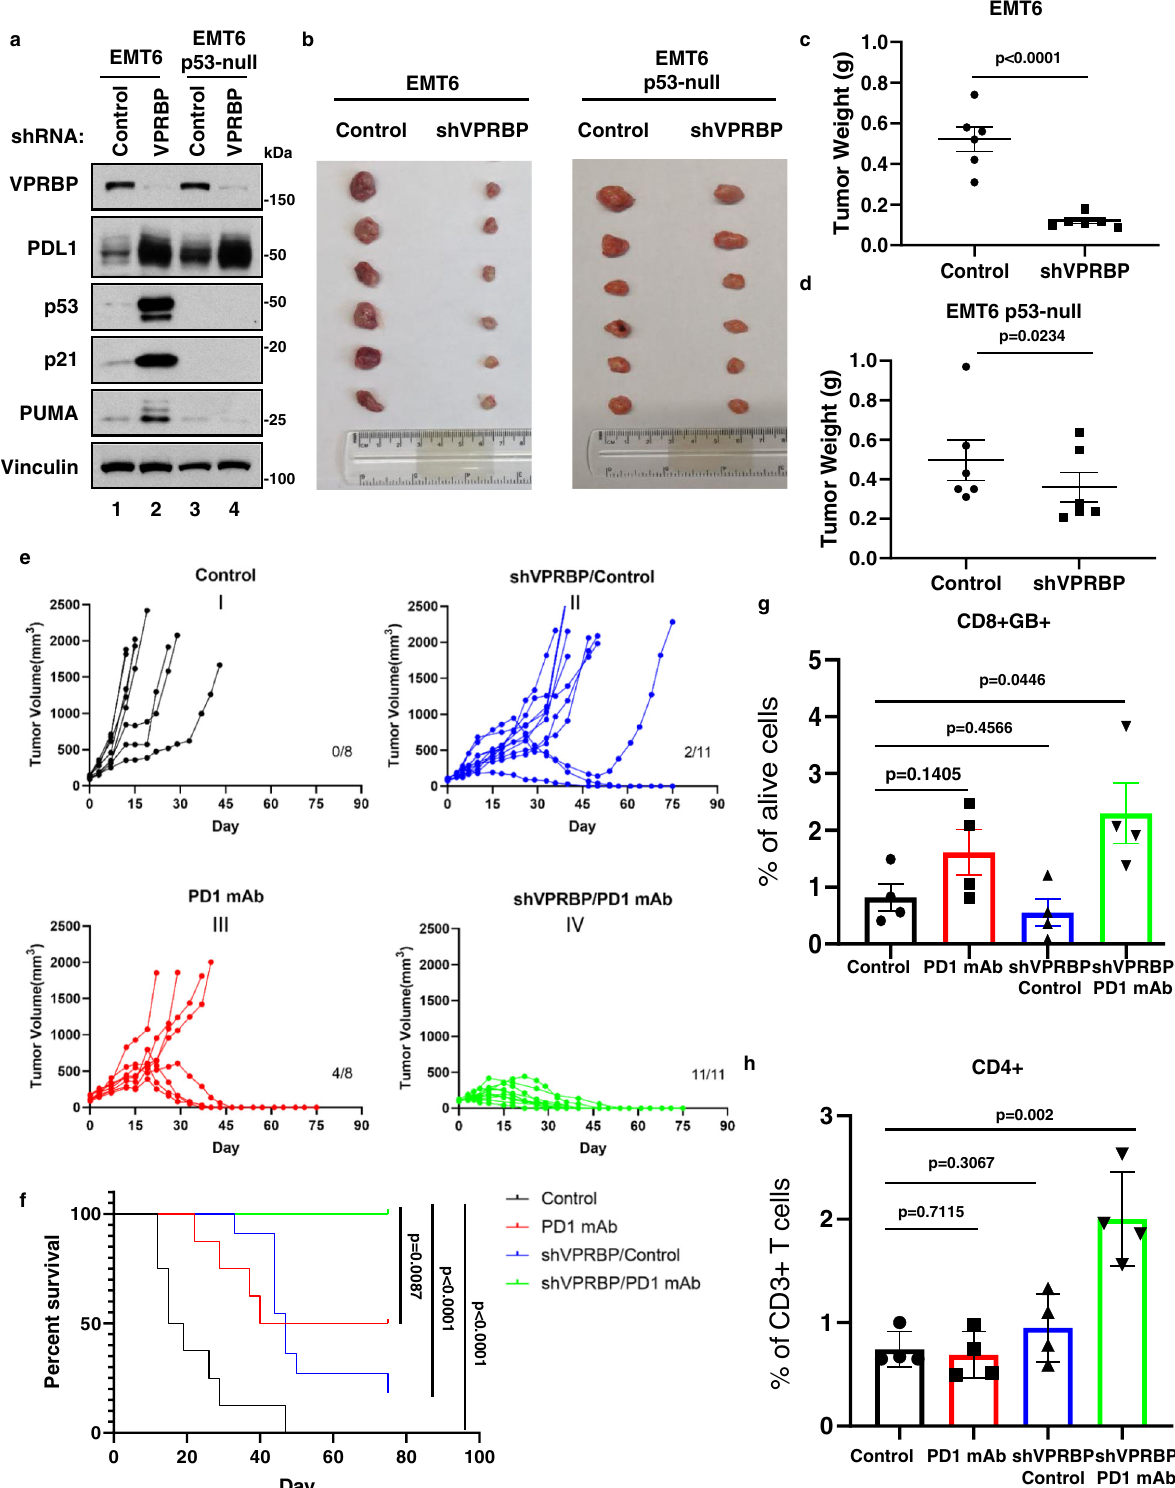
Fig.4|CombinationtreatmentwithVPRBPinhibitionandimmunecheckpoint blockade activates p53 and enhances immunotherapeutic ef fi cacy. a Western blotanalysisofEMT6andEMT6 p53